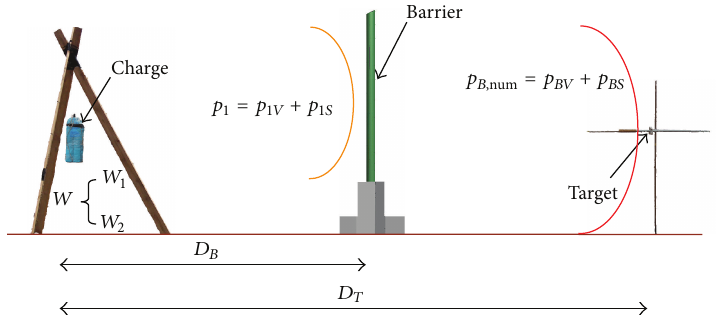
Figure 11: Geometrical representation of the proposed model.